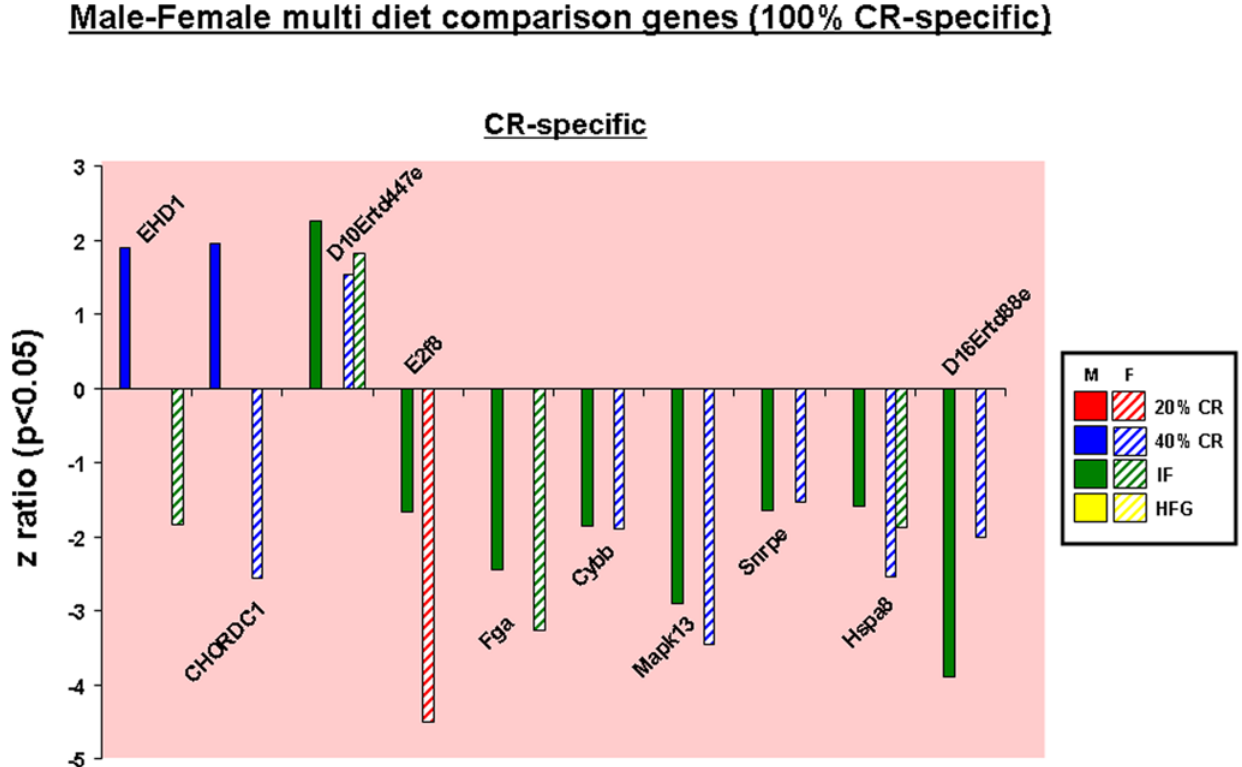
Figure 8. Caloric specificity of male-female multi-diet regulated genes. Significantly altered genes that were common between one or more of the diet paradigms in the ovaries and the testes were drawn to visualize caloric specificity in cross-gender regulated genes. Names of the significantly altered genes can be found in Table S1.